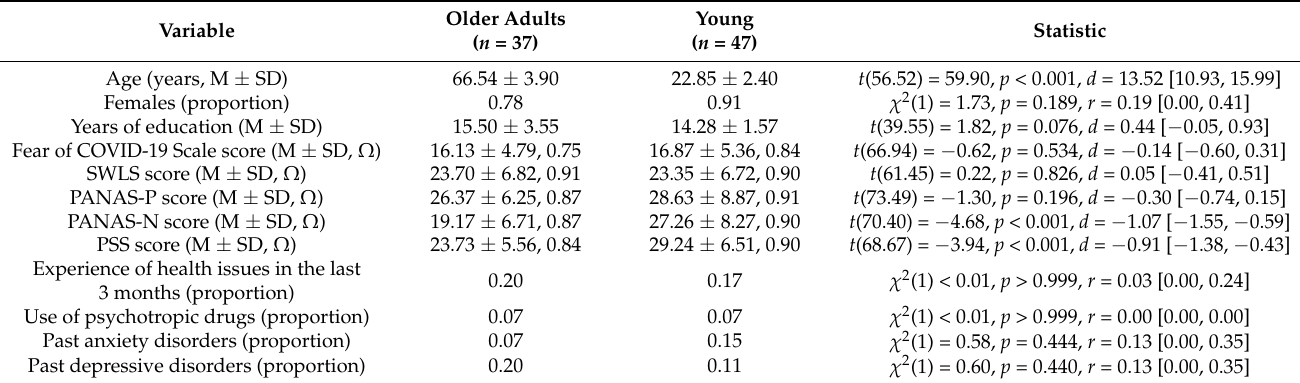
Table 1. Descriptive statistics of background variables and results of the comparisons between age